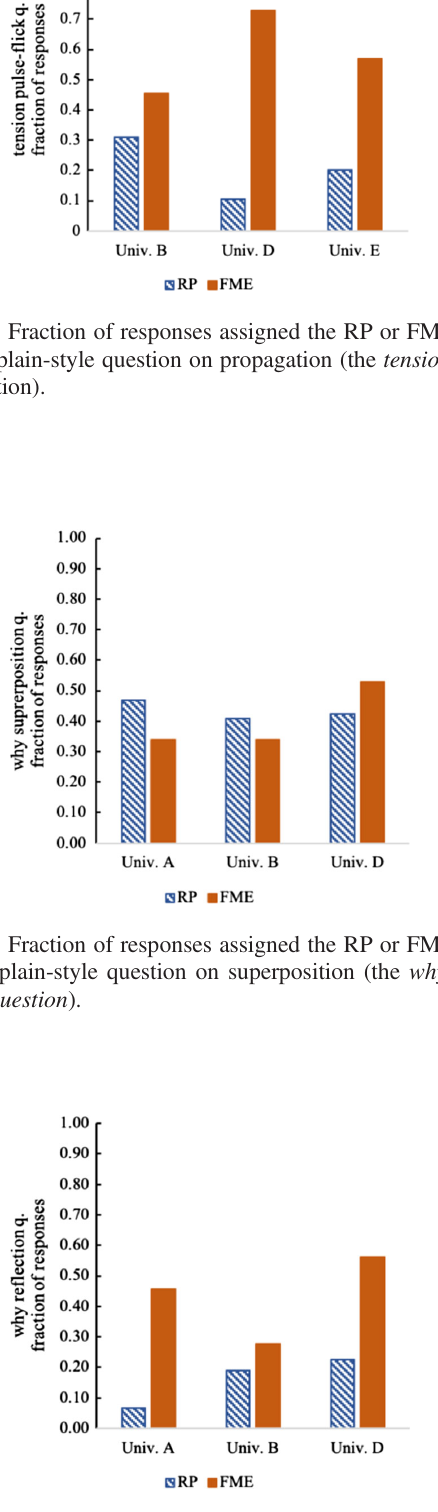
FIG. 14. Fraction of responses assigned the RP or FME codes for the predict-style question on reflection (the cups question).